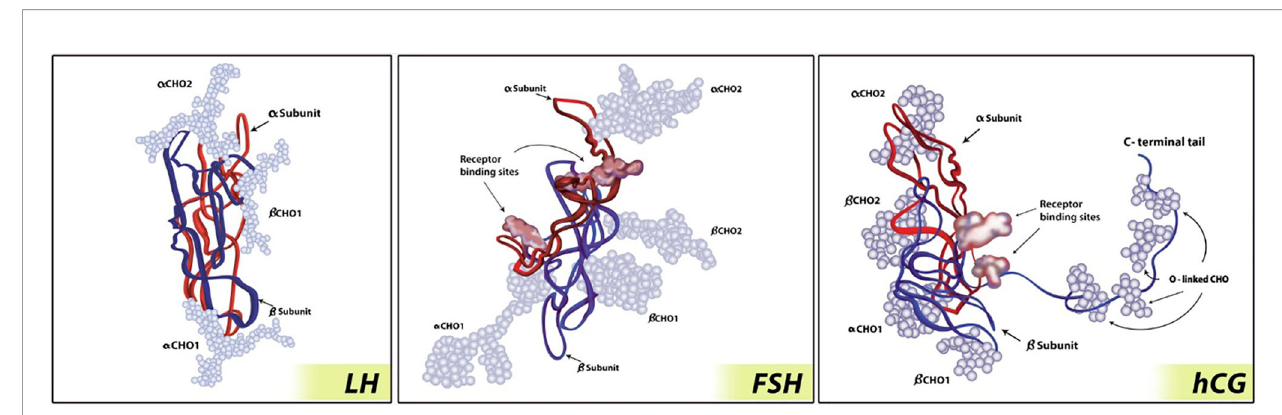
FIGURE 3 | Glycoprotein hormone molecule (73). hCG has the largest size of the glycoprotein hormones due to carboxy-terminal addition. The a -subunits are represented by red strand; the b -subunits are represented by blue strand; carbohydrate chains are represented by light blue balls. Figure from SpringerLink (73) permissible to reuse under a CC-BY 4.0 license.